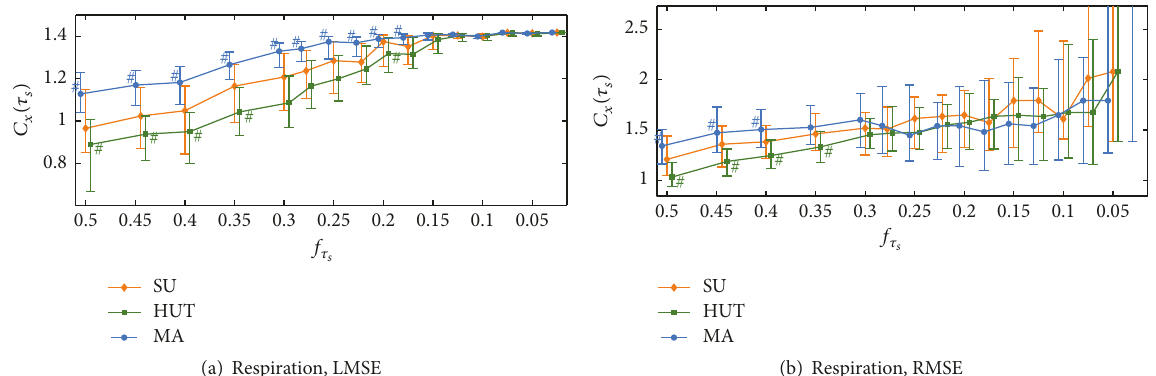
Figure 5: Estimation of multiscale entropy (MSE) for the time series of respiration. Plots depict the distributions (median and 25th–75th percentiles) of the MSE estimates (𝐶 𝑥 (𝜏 𝑠 )) computed as a function of the cutoff frequency of the low-pass filter used to eliminate the fast ) in the resting supine position (SU, diamonds), during postural stress induced by head-up tilt (HUT, temporal scales of the process (𝑓 𝜏 𝑠 squares), and during mental stress induced by mental arithmetics (MA, circles). The multiscale complexity of respiratory dynamics increases consistently across multiple time scales during MA and decreases for time scales associated with high-frequency oscillations during HUT. # Statistically significant difference, HUT versus SU or MA versus